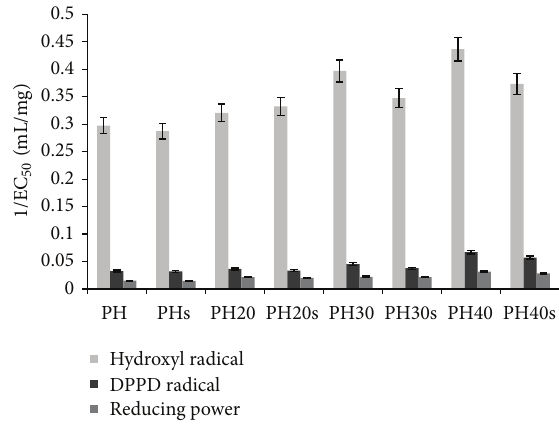
Figure 1: 1/ EC 50 values of honey